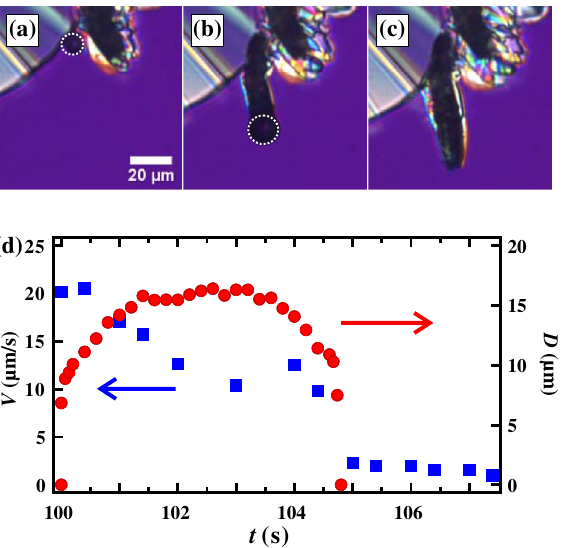
Figure 3. Microscopy observation of filamentous crystal growth in OTP at 278 K. ( a ) t = 100.0 s , ( b ) 103.0 s, and ( c ) 105.5 s. The dotted line indicates the bubble, which induces filamentous crystal growth. ( d ) The time evolution of the growth rate of the filamentous crystal (squares) and the diameter of the bubble (circles). The bubble disappears at t = 105.5 s ; the growth rate also suddenly decays toward the bulk growth rate. The measurement errors are smaller than the symbol size.